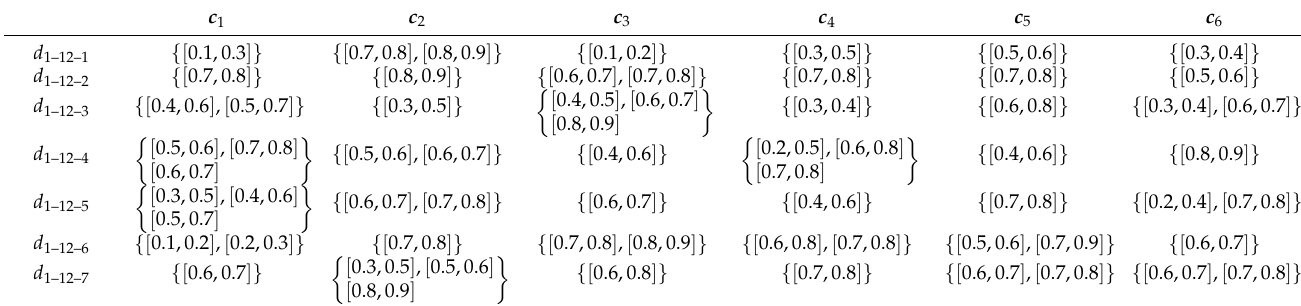
Table A12. Scoring matrix of innovation d 1–12 .